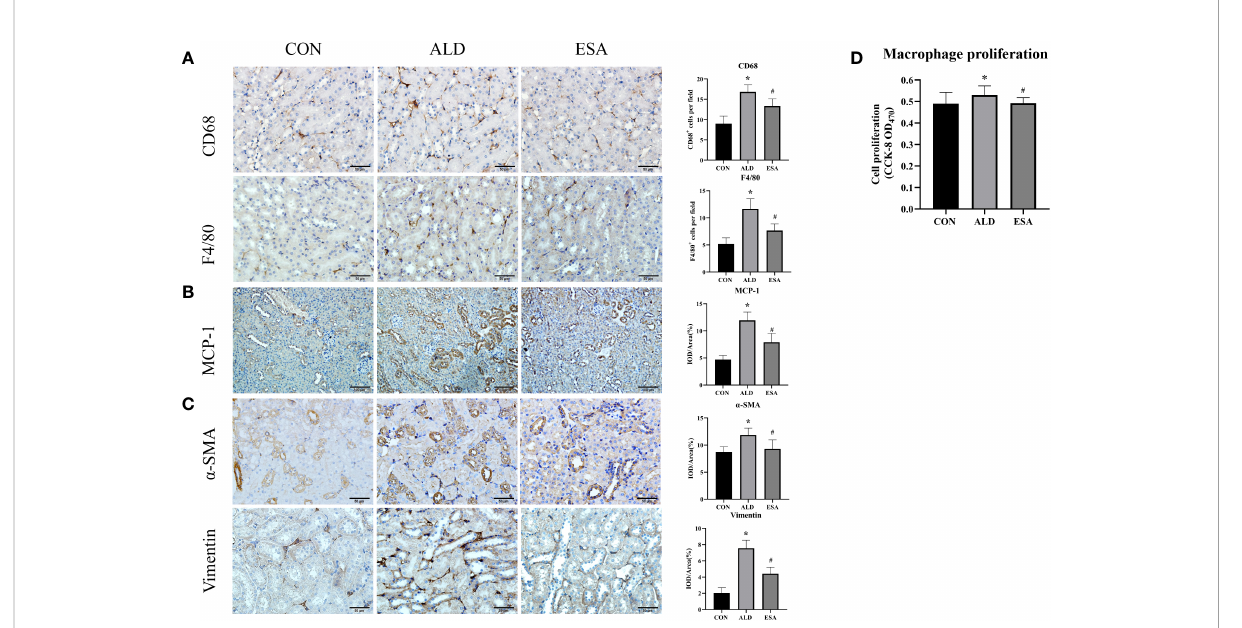
FIGURE 2 ESA antagonized the increased in fi ltration of macrophages and myo fi broblasts. (A) Immunohistochemical staining using antibodies against CD68 and F4/80 to examine renal in fi ltration of macrophages (n = 6). (B) Immunohistochemical staining using antibodies against MCP-1 to examine the migration and in fi ltration of macrophages (n = 6). (C) Immunohistochemical staining using antibodies against a -SMA and vimentin to examine renal in fi ltration of myo fi broblasts (n = 6). (D) CCK8 assays measured ALD-induced proliferation of RAW264.7 cells (n = 12). The data are presented as the mean ± SD, *p < 0.05 vs. the CON group, # p < 0.05 vs. the ALD group. ESA, esaxerenone; CCK8, Cell Counting Kit-8; ALD,